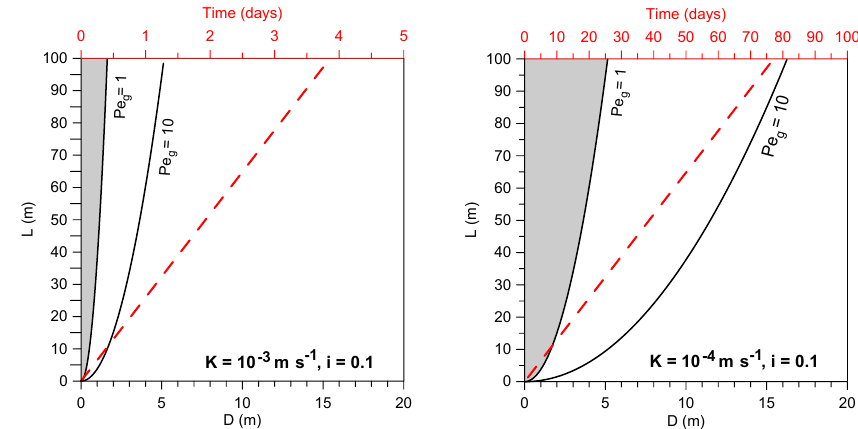
Figure 15. Threshold values of the geothermal Péclet number as a function of distance along the seepage path ( L ) and thickness of the sand layer ( D ) for two different values of hydraulic conductivity. The dotted red line indicates the arrival times of the thermal front; these must be read on the top x axis as a function of distance L .